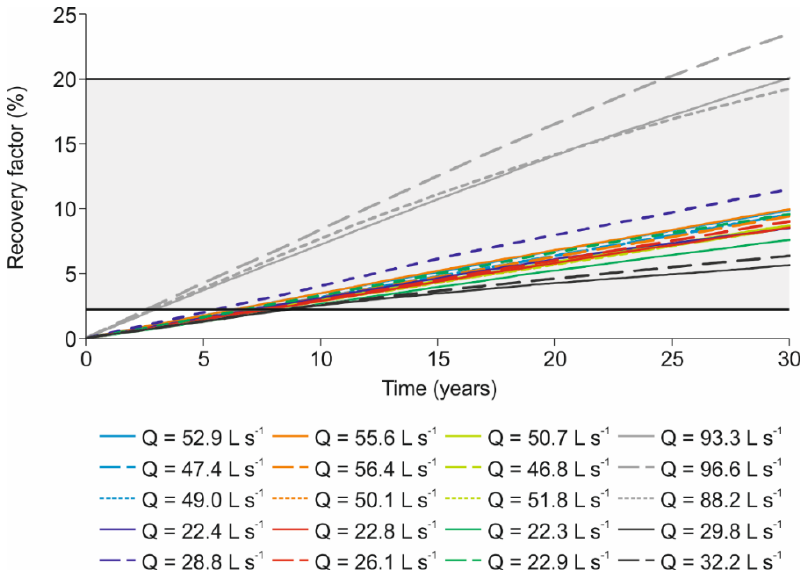
Figure 13. Recovery factor over time. Grey polygon—theoretical values for the recovery factor, lower bound = 2%, upper bound = 20% (e.g., [35,78]). The reader is referred to Tables 4 and 5 for further details on the flow rates.